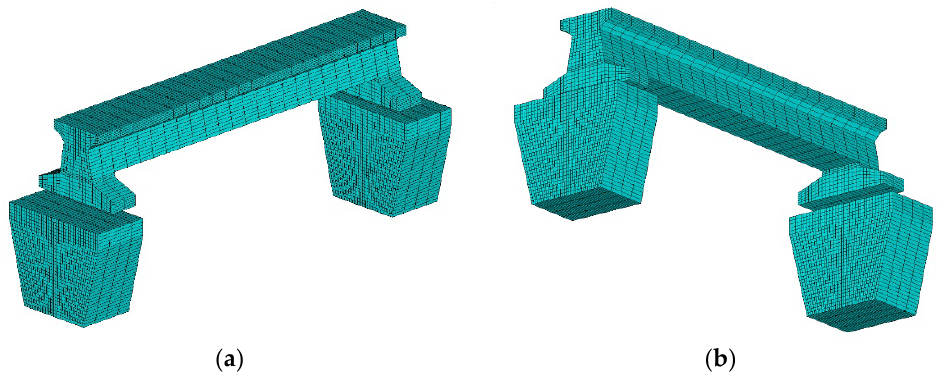
Figure 11. The three-dimension FE model with meshed elements. ( a ) Top view; ( b ) bottom view.